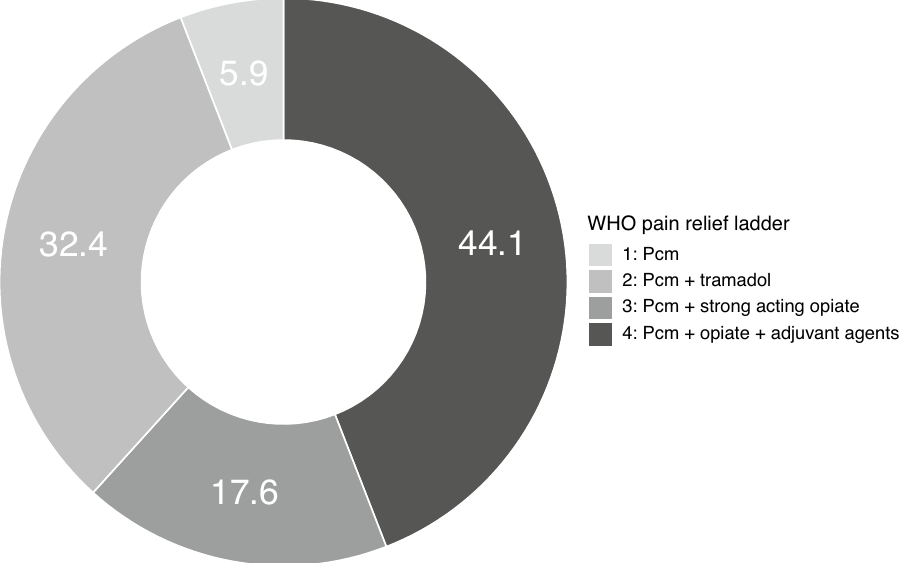
Figure 2. Distribution (in %) of pain severity (classified as steps in the WHO pain relief ladder) in patients with myalgia in the TREO cohort ( Pcm paracetamol).